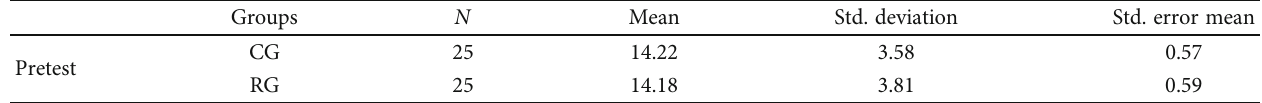
Table 1: Group statistics (pretest of both